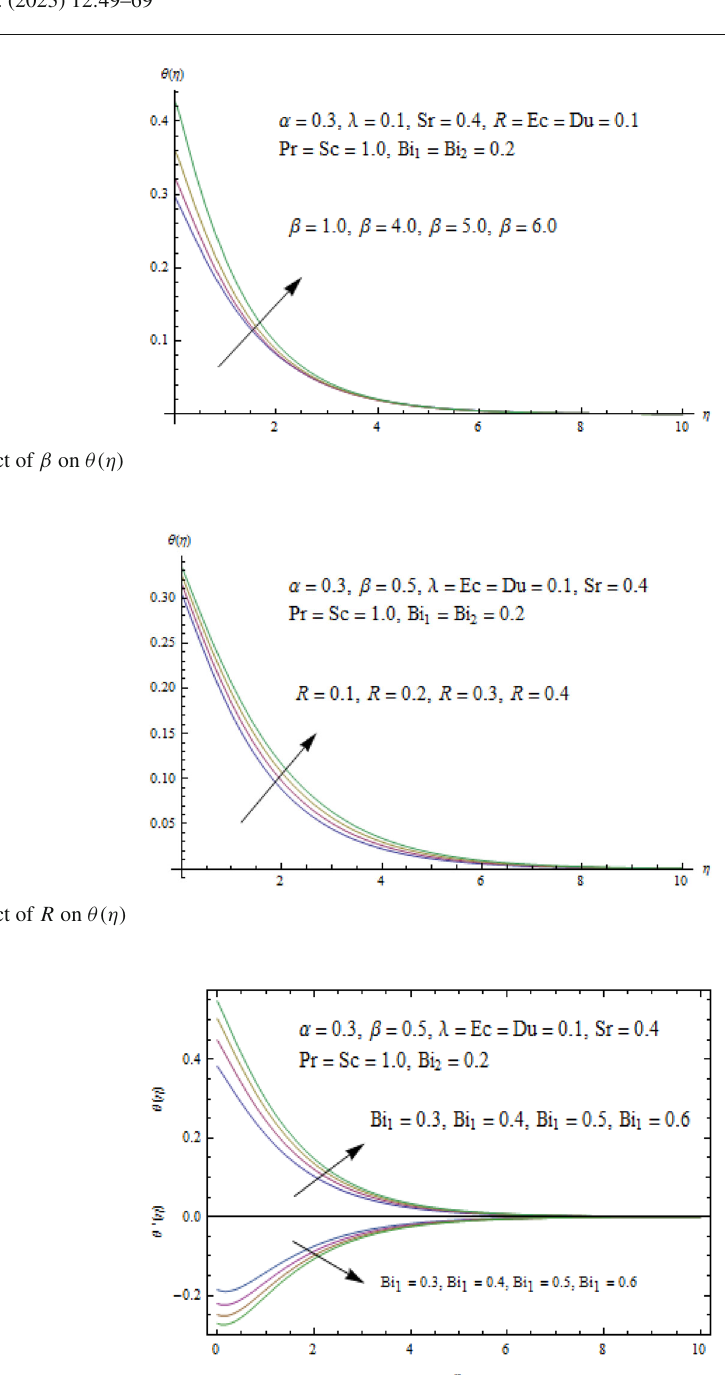
Fig. 15 Impact of Bi 1 on θ(η) and θ (cid:5)